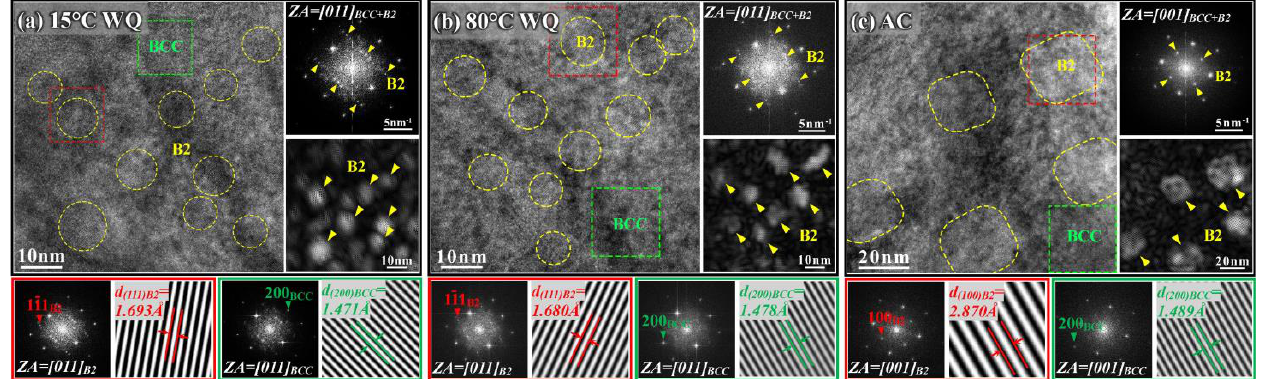
Figure 5. HRTEM images, FFT images and FFT filtered images for the solution-treated 6Ni2Mo alloy subjected to 15 °C WQ ( a ), 80 °C WQ ( b ) or AC ( c ). Note that the results in the red and green solid box were from the corresponding red and green dashed areas in the HRTEM images, respectively.